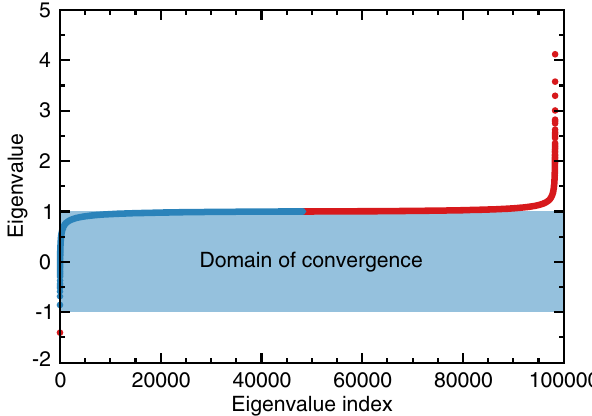
A (see main text for od d